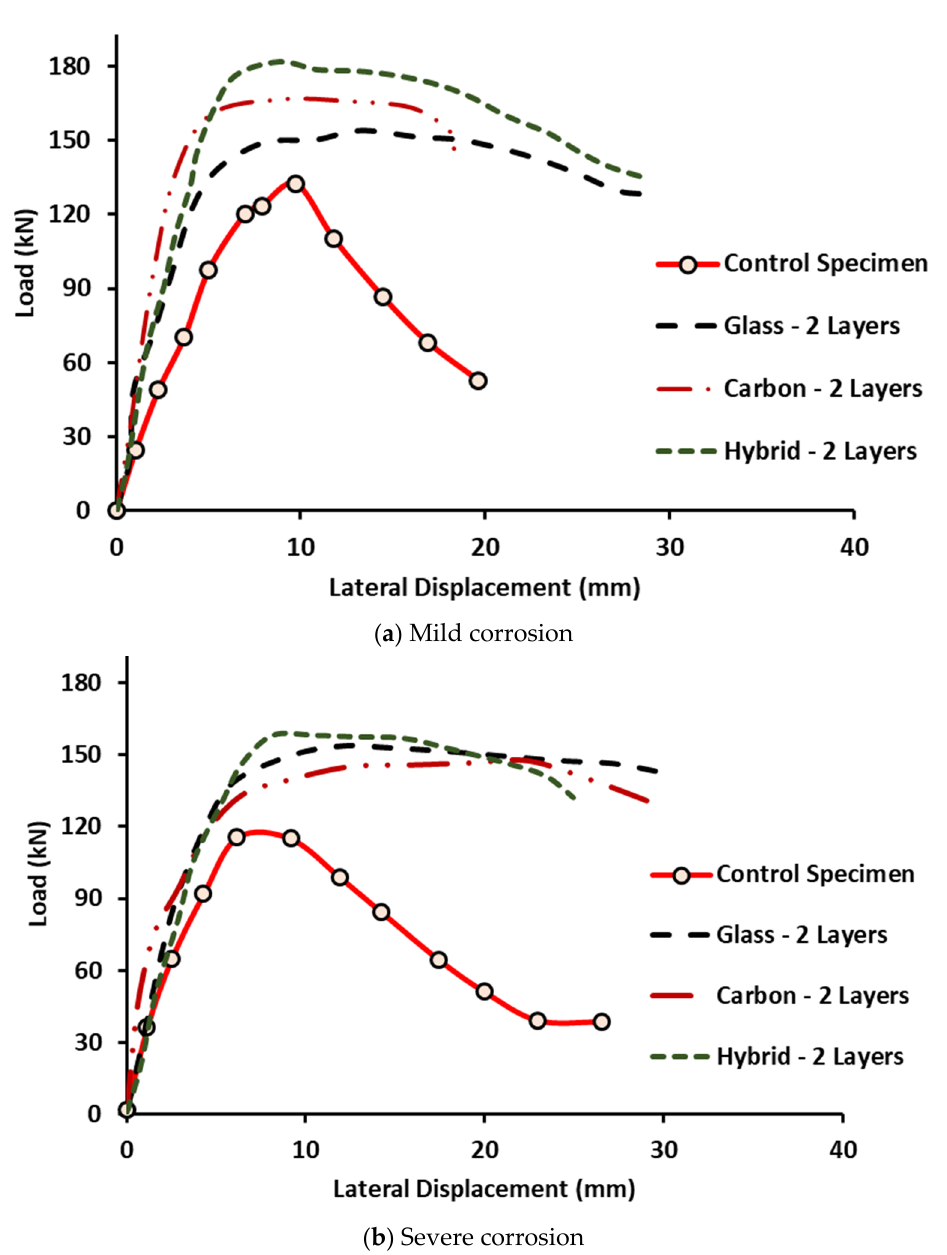
Figure 16. Load versus displacement curves for mild and severely corroded RC columns with and without FRP strengthening. Reproduced from [20].